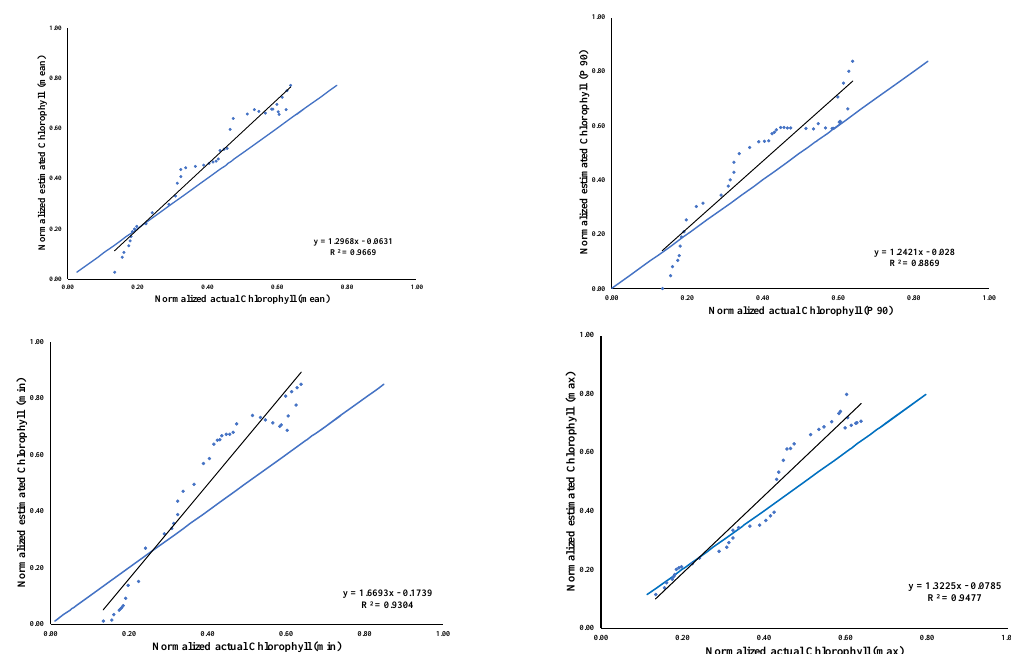
Figure 2. Maximum chlorophyll index (MCI) regression analysis with respect to different zonal statistics values.